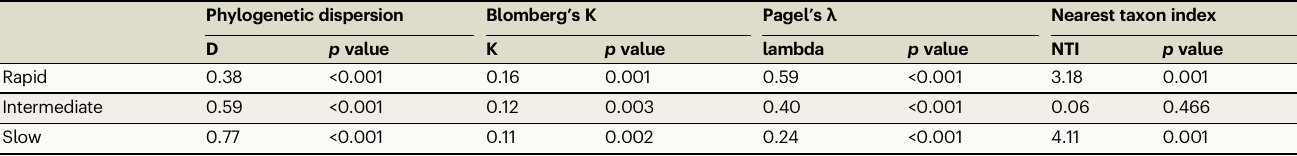
Table 1 | Phylogenetic indices of three growth strategies